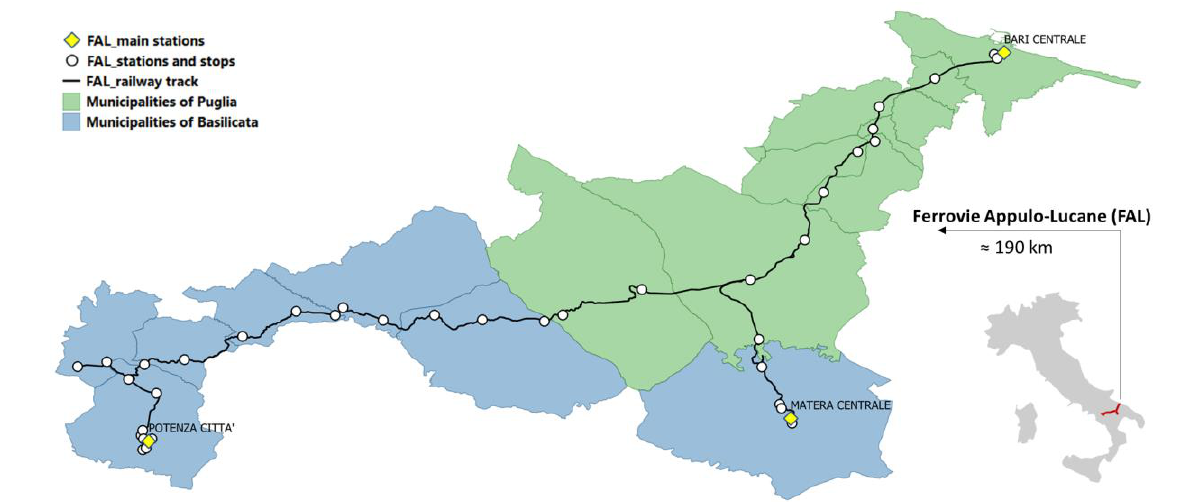
Figure 4. The railway-line network of Ferrovie Apulo-Lucane (FAL) with stations and stops. Data sources: rail lines and junctions from National and Regionals geodatabases, administrative boundaries from